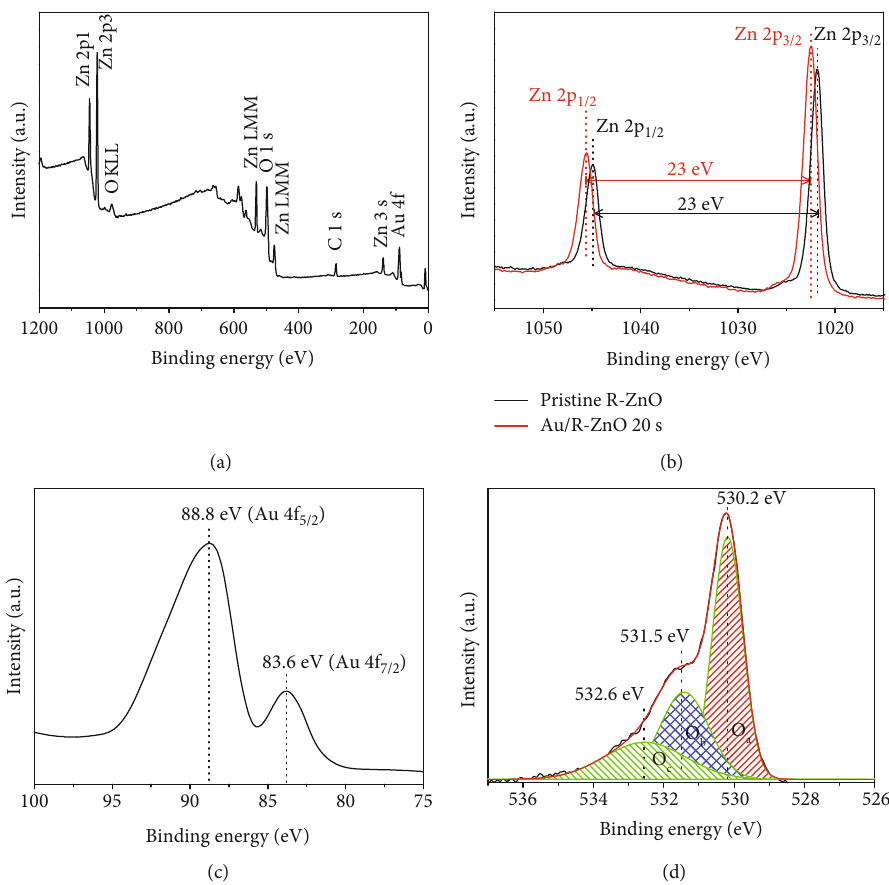
Figure 7: X-ray photoelectron spectroscopy (XPS) characterizations for pristine R-ZnO and Au/R-ZnO 20s. (a) XPS survey of scan spectrum for Au/R-ZnO 20s, (b) Zn 2p of pristine R-ZnO, and Au/R-ZnO 20s, respectively. (c) Au 4f for the sample of Au/R-ZnO 20s. (d) O 1s core level fi tting of Au/R-ZnO 20